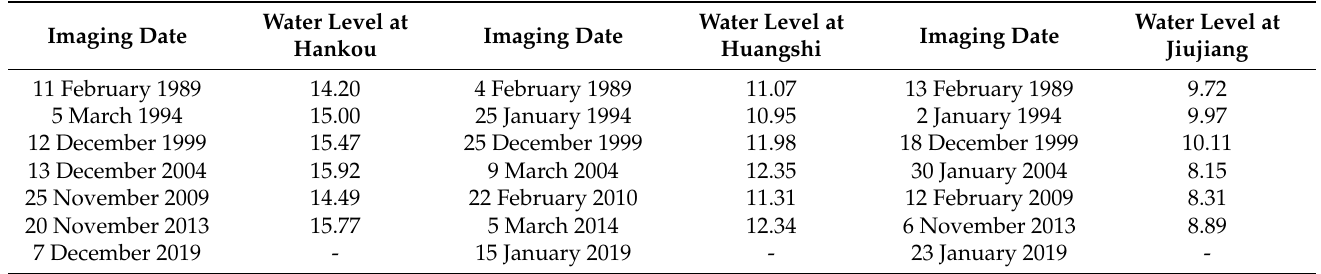
Table 1. Water levels of the Chenglingji to Datong River section on imaging days during the dry season (m).